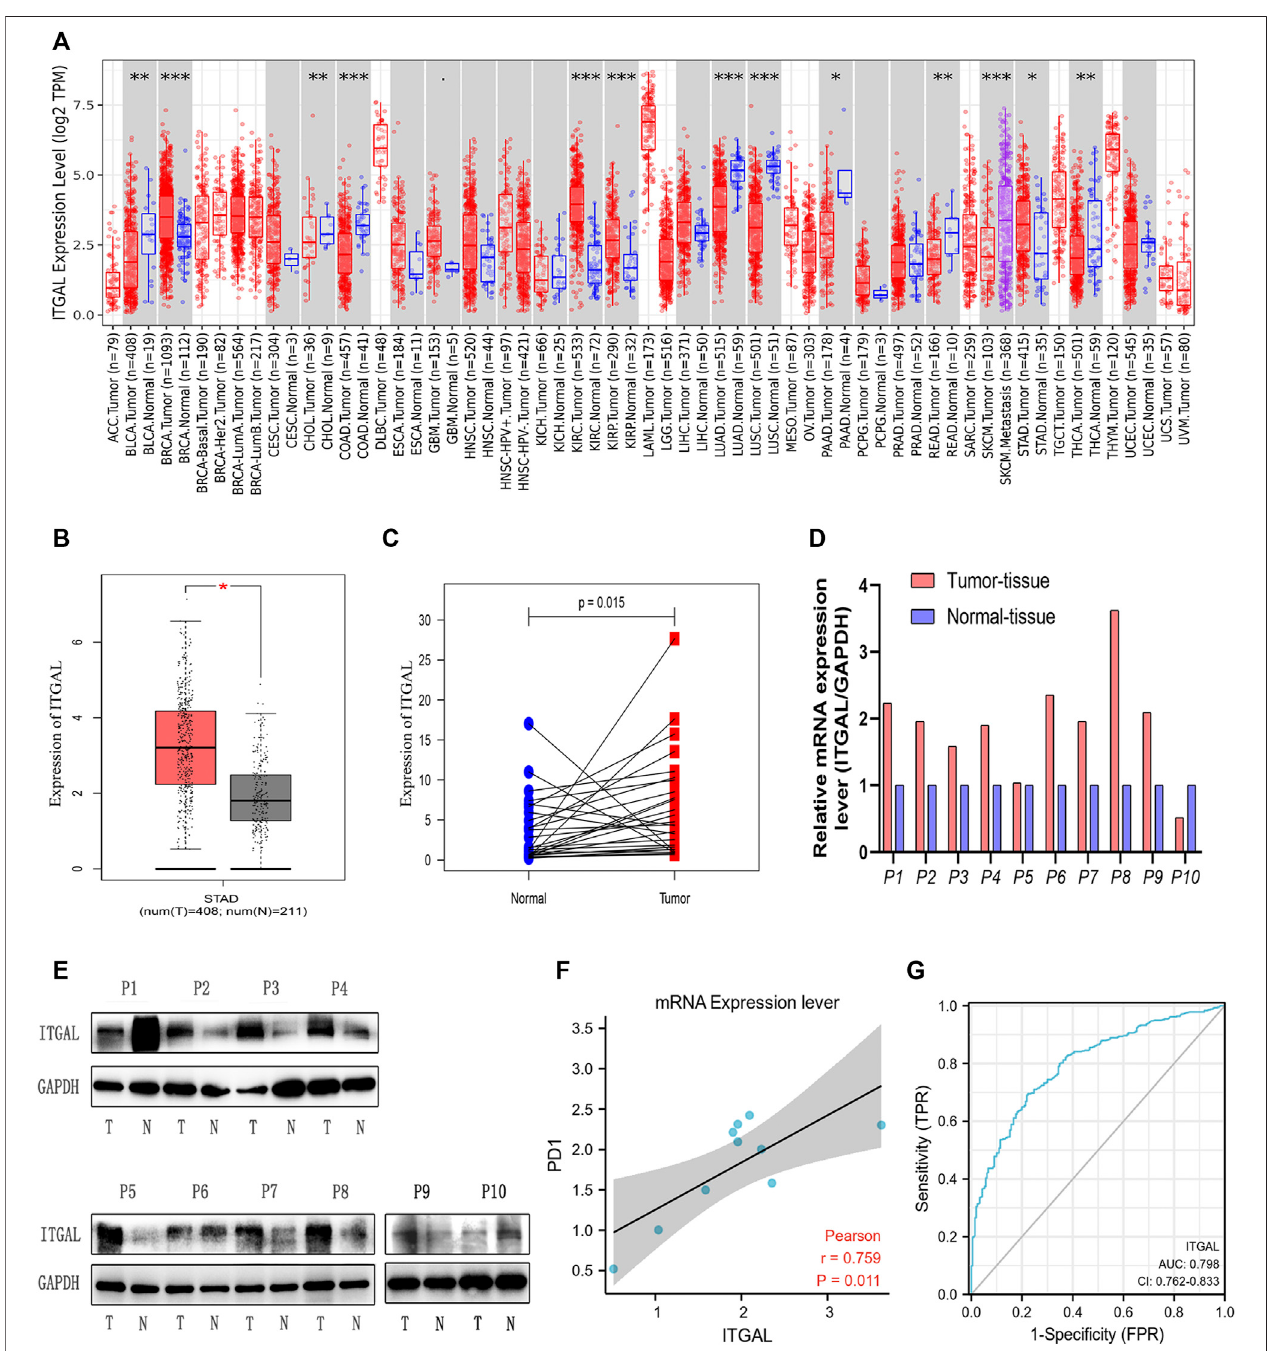
FIGURE 1 | Integrin alpha L (ITGAL) expression levels in different types of human cancers. (A) Increased or decreased ITGAL in different tumor types from The Cancer Genome Atlas (TCGA) database were determined by Tumor Immune Estimation Resource (TIMER) (* p < 0.05, ** p < 0.01, *** p < 0.001). (B) Increased ITGAL in gastric cancer tissues compared with normal tissues in Gene Expression Pro fi ling Interaction Analysis (GEPIA). (C) Increased ITGAL expression in gastric cancer compared with the matching normal tissue from TCGA database ( n = 27). (D) The mRNA level of ITGAL in 10 pairs of GC tissues and their paired normal adjacent tissues. (E) Western blotting was used to detect the protein level of ITGAL in 10 pairs of GC tissues and their paired adjacent normal tissues. (F) The correlation analysis between ITGAL and PD1 mRNA level. (G) The receiver-operating characteristic (ROC) curve analysis of ITGAL in gastric cancer (GC) patients.